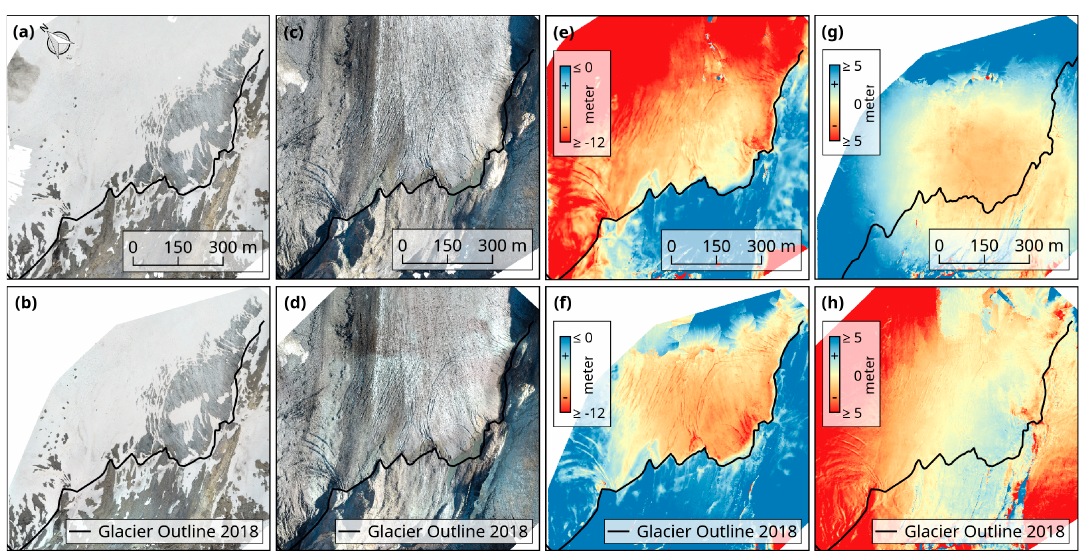
Figure 6. Comparison of OpenDroneMap and Pix4D outputs. ( a ) OpenDroneMap and ( b ) Pix4D orthophotos from 3 June 2018. ( c ) OpenDroneMap and ( d ) Pix4D orthophotos from 29 September 2018. ( e ) Elevation change over the melt season 2018 based on the OpenDroneMap DSM di ff erence between 3 June and 29 September. ( f ) Elevation change over the melt season 2018 based on the Pix4D DSM di ff erence between 3 June and 29 September. ( g ) OpenDroneMap and Pix4D DSM di ff erence from 3 June and ( h ) 29 September 2018, respectively.